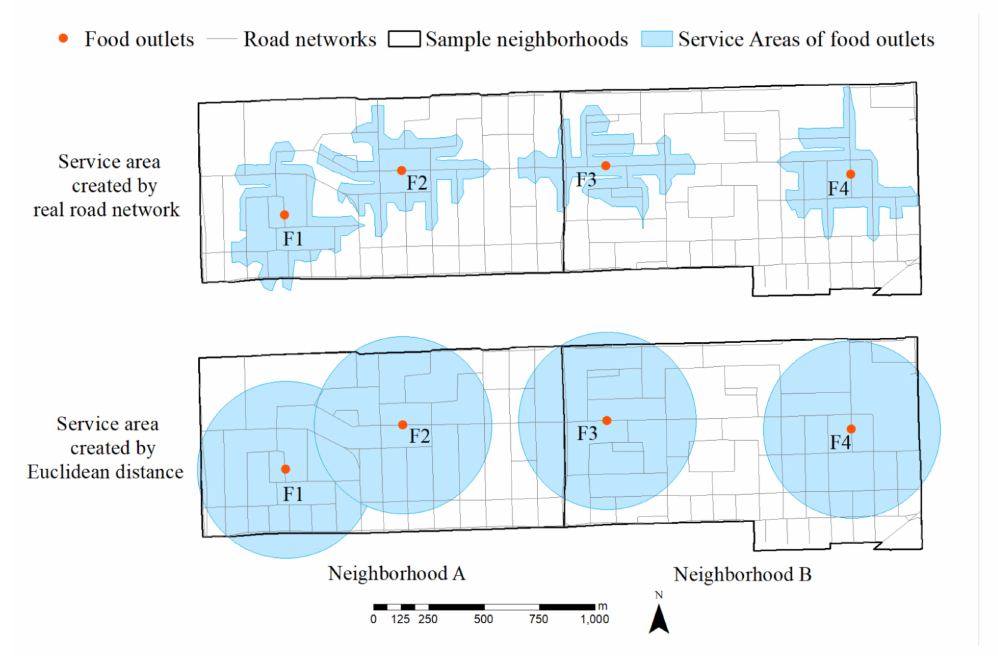
Figure 1. An illustration of service areas using road network and